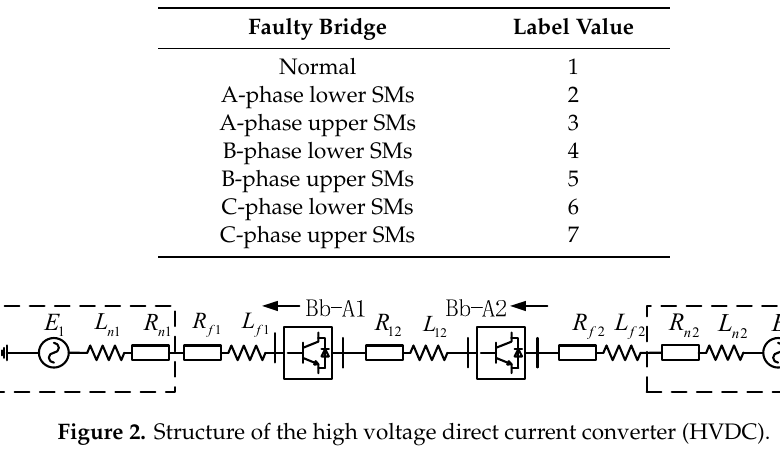
Table 2. MMC health conditions.